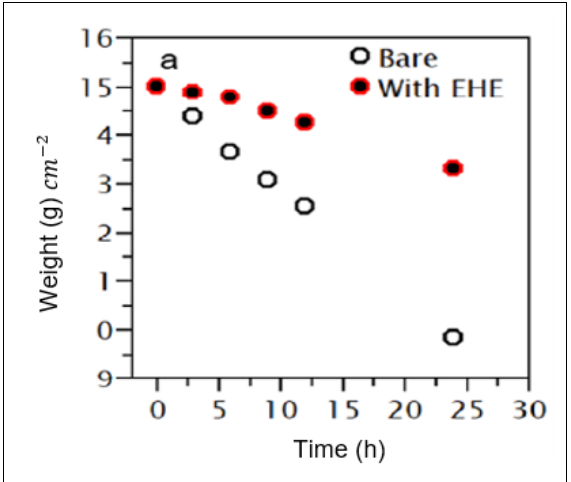
Figure 14. Comparison of weight loss between blank solution and solution with the presence of Equisetum hyemale extract (EHE ). Reprinted from [78].